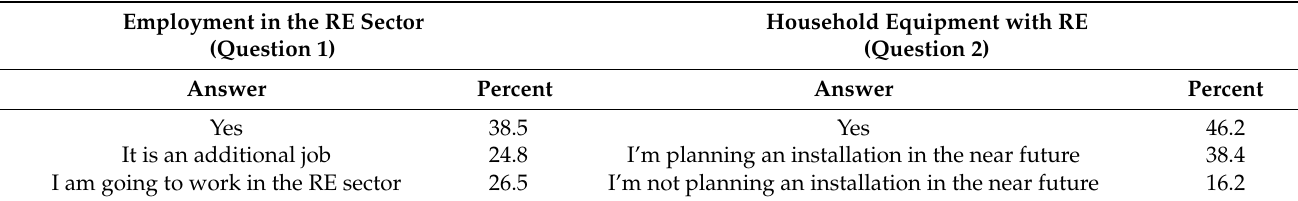
Table 3. Employment and possession of RE installations among the